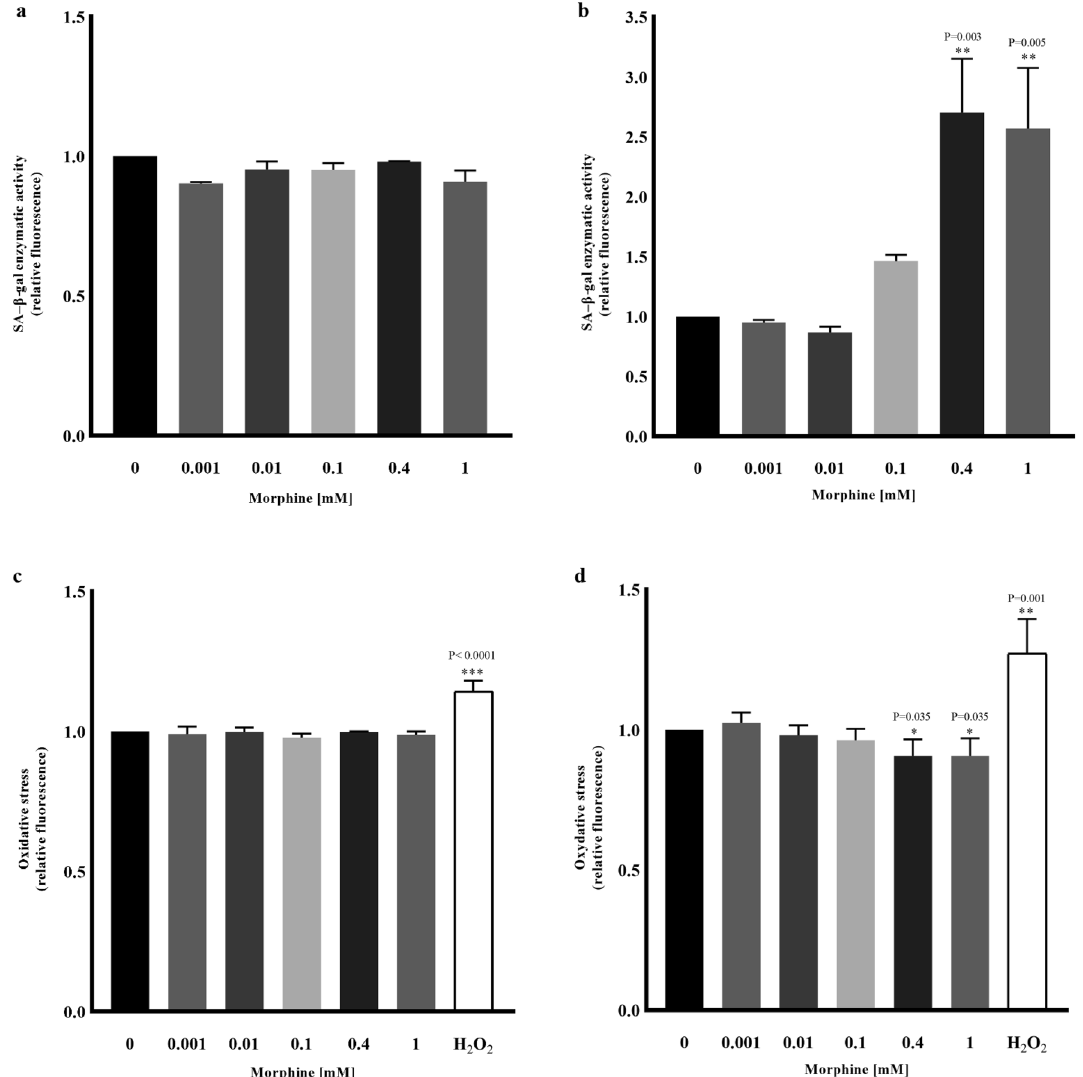
Figure 3. SA-β-Gal assay and ROS analysis carried out after nine and eighteen days of morphine exposition. The reported values are expressed as mean ± SD of three independent experiments and represented as fluorescence variations compared to non-treated sample (0 mM). ( a ) Nine days of morphine treatment did not induce any increase of SA-β-Gal enzymatic activity. ( b ) Eighteen days of morphine treatment induced on the contrary, a marked enzymatic activity. ( c ) Nine days of morphine exposition did not induce significant oxidative stress effect. ( d ) Compared to the non-treated sample, eighteen days displayed oxidative stress decrease both at 0.4 and 1 mM. White bar represented in both plot refers to hydrogen peroxide used as positive